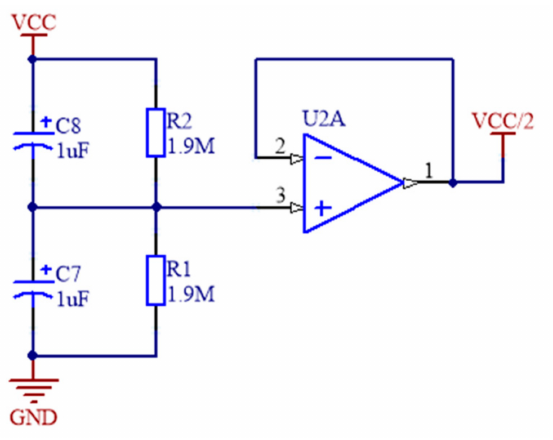
Figure 3. Virtual Ground for power supply splitting from the lithium-ion